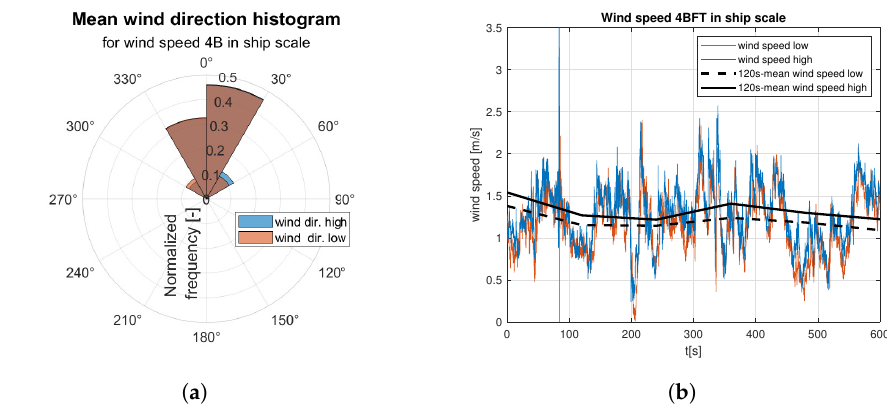
Figure 9. Raw measurements for weak wind—4BFT in ship scale: ( a ) wind rose; ( b ) time series. Figures 8 and 9 illustrate raw measurements of the weak wind. In mean wind direction histogram for 3B (Figure 8a) in ship scale a much smaller data dispersion is observed than for 4B in ship scale (Figure 9a).